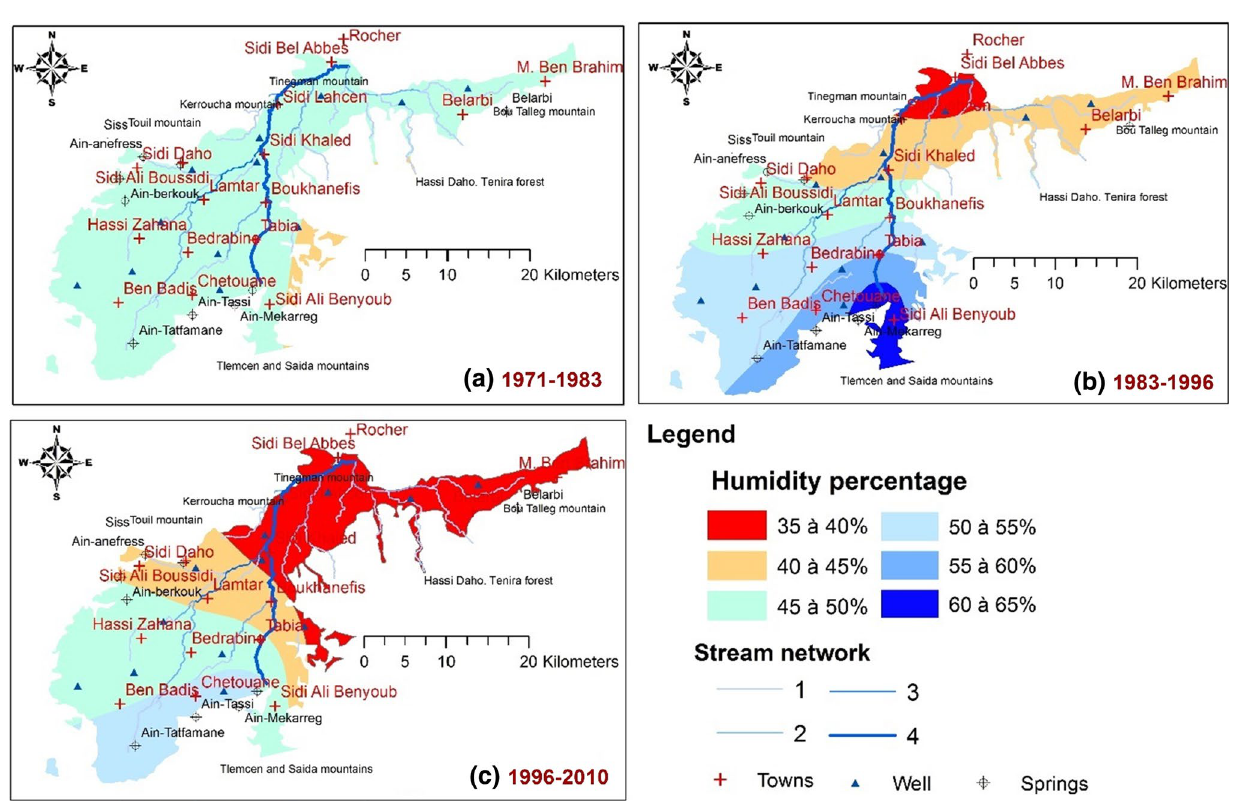
Fig. 9 Spatiotemporal distribution of humidity values for each period